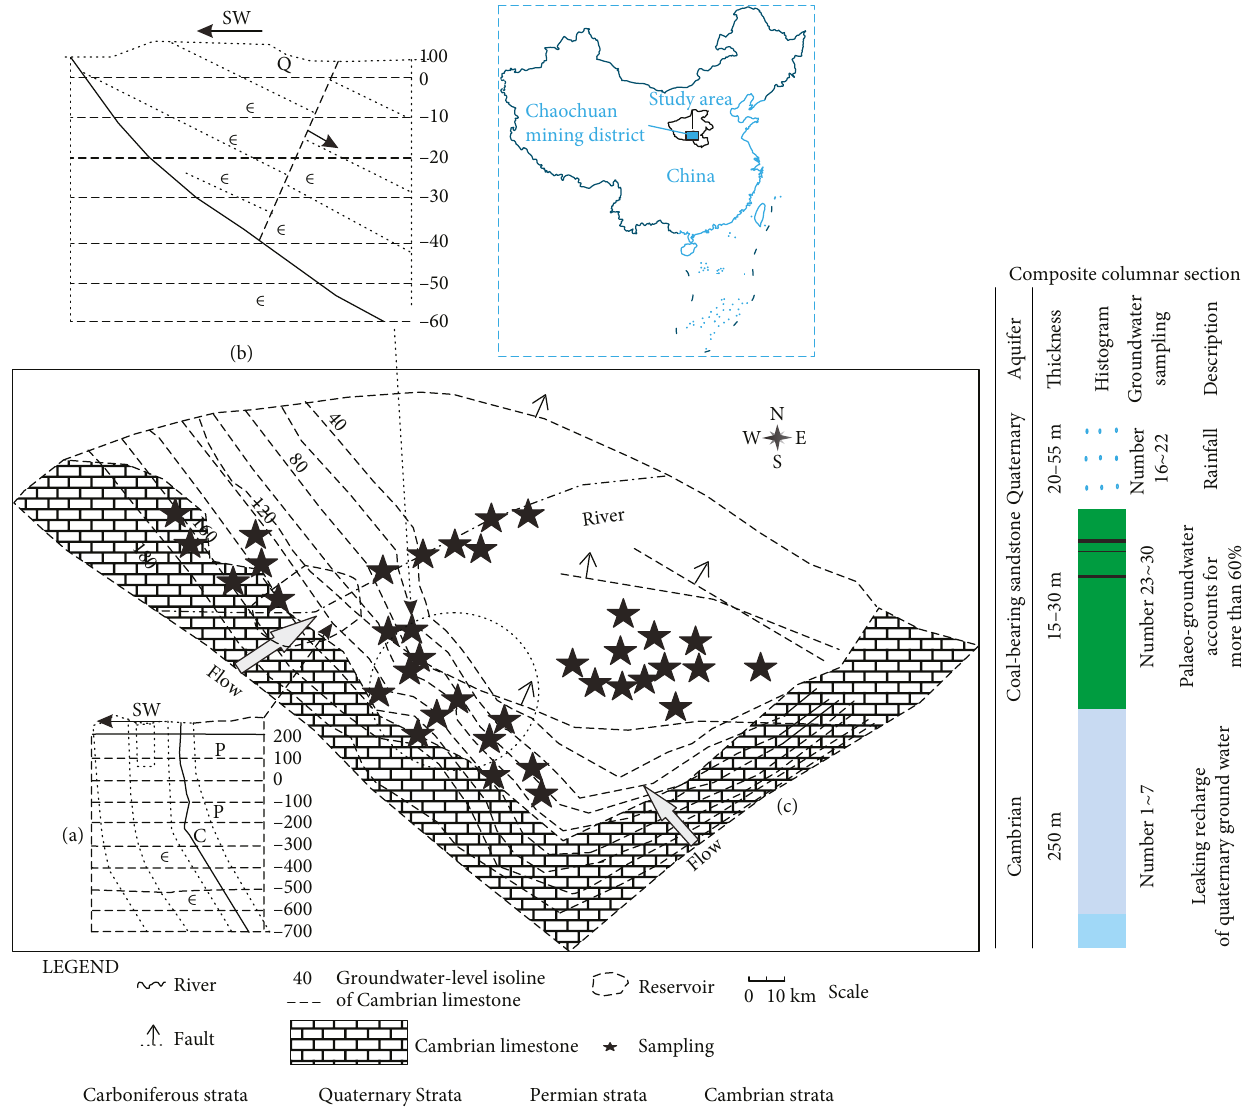
Figure 1: Hydrogeological map of the Chaochuan coal mining district in China. C: Carboniferous strata; Q: Quaternary strata; P: Permian strata; ϵ : Cambrian